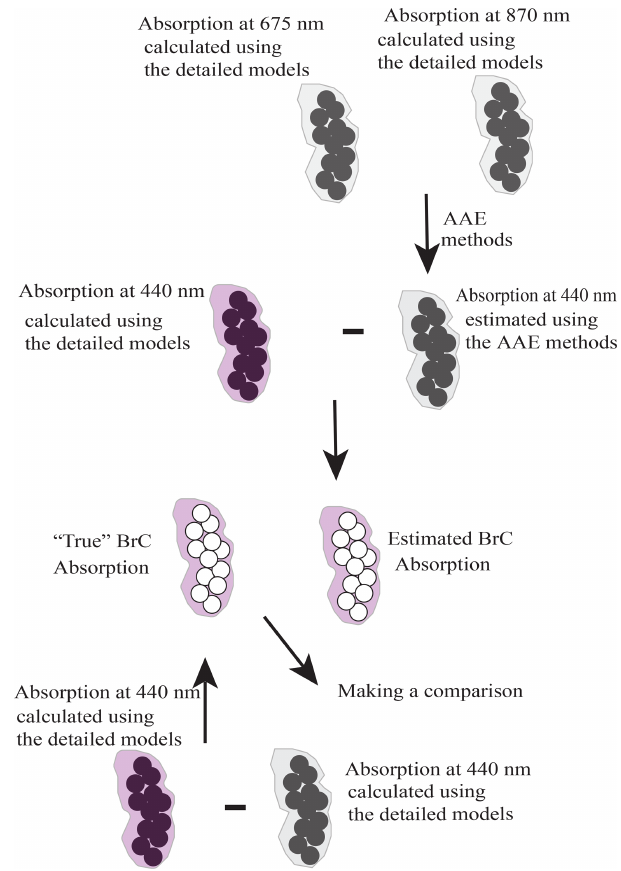
Figure 1. The estimation of BrC absorption.